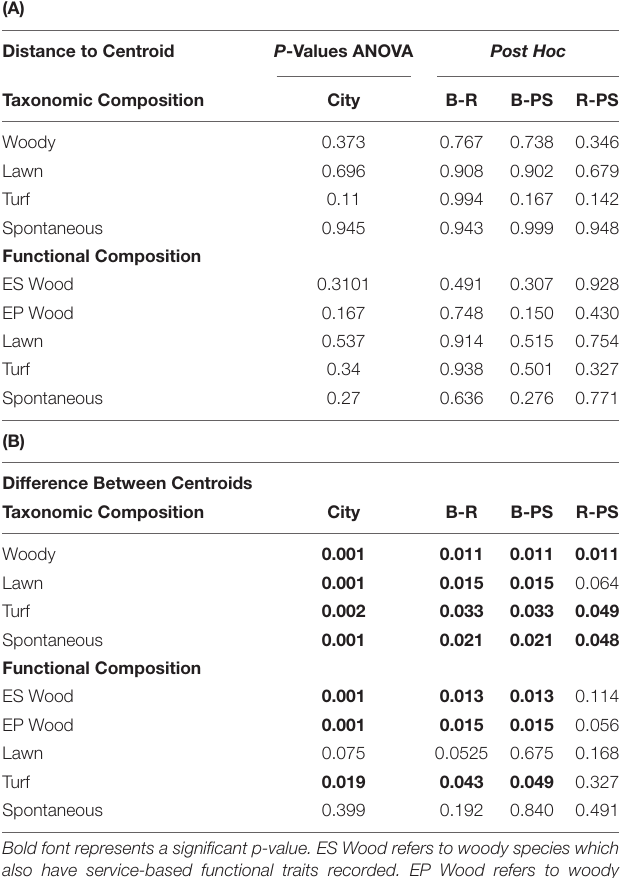
TABLE 3 | (A) P -values for homogeneity of multivariate dispersions, by group and post hoc results. (B) P -values for difference between centroids of groups, ANOVA and post hoc